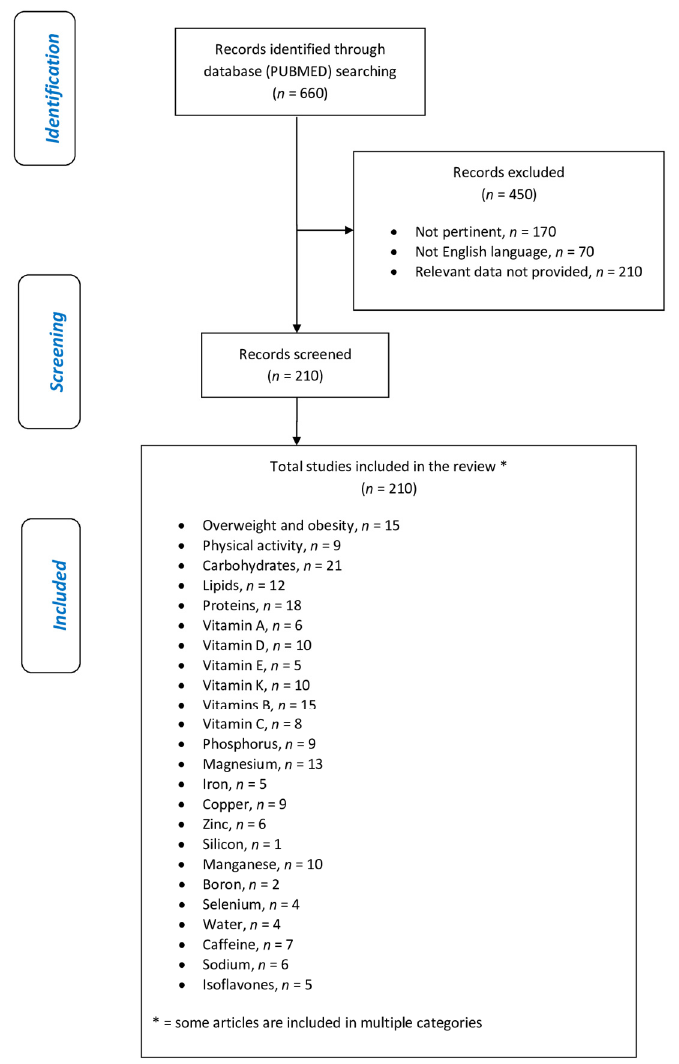
Figure 1. Flow chart of the literature research.